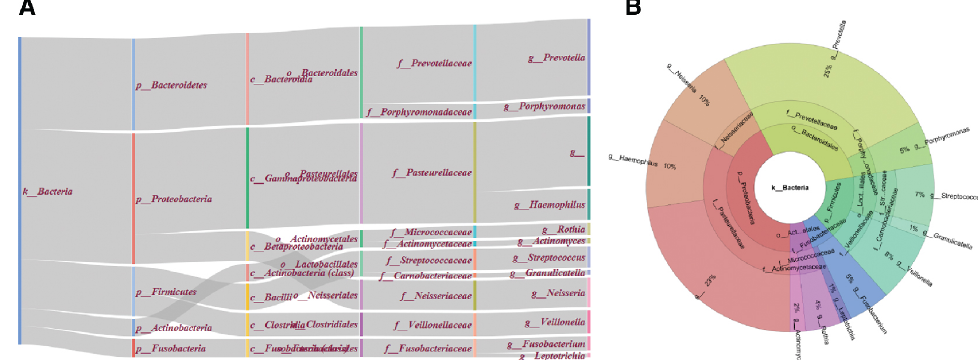
Figure 2: Illustration of the taxonomic distribution of the most abundant genera from the tongue tissue as described in Caporaso et al. [32]. On the left side (subfigure A) is the diagram generated by BioSankey , on the right side (subfigure B) is the diagram generated by the tool Krona (Ondov et al. [1]. The information in both diagrams is the same, the difference – except style, is that the Sankey diagram is read left to right from general to more specific (= to lower taxonomic ranks) and the Krona diagram from inside to outside.